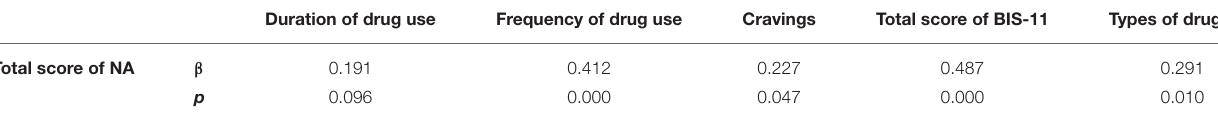
TABLE 3 | Univariate regression of drug use characteristics, cravings, impulsivity, and NA.